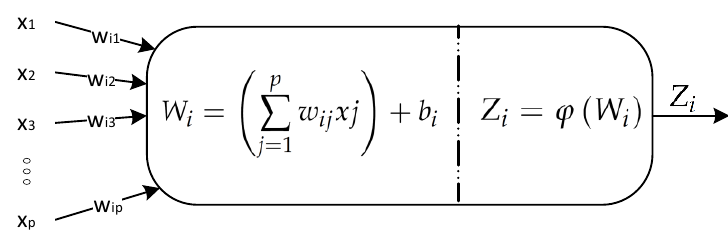
Figure 7. Structure of an ANN